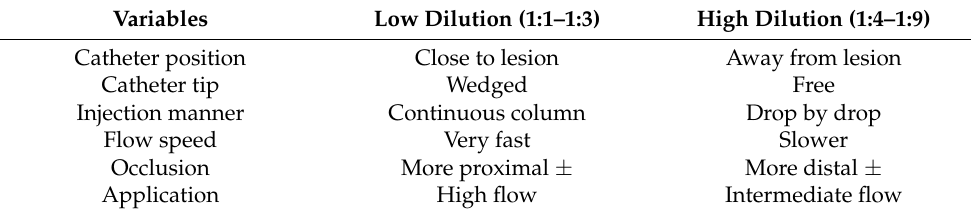
Table 3. Choosing glue/lipiodol dilution according to the situation.